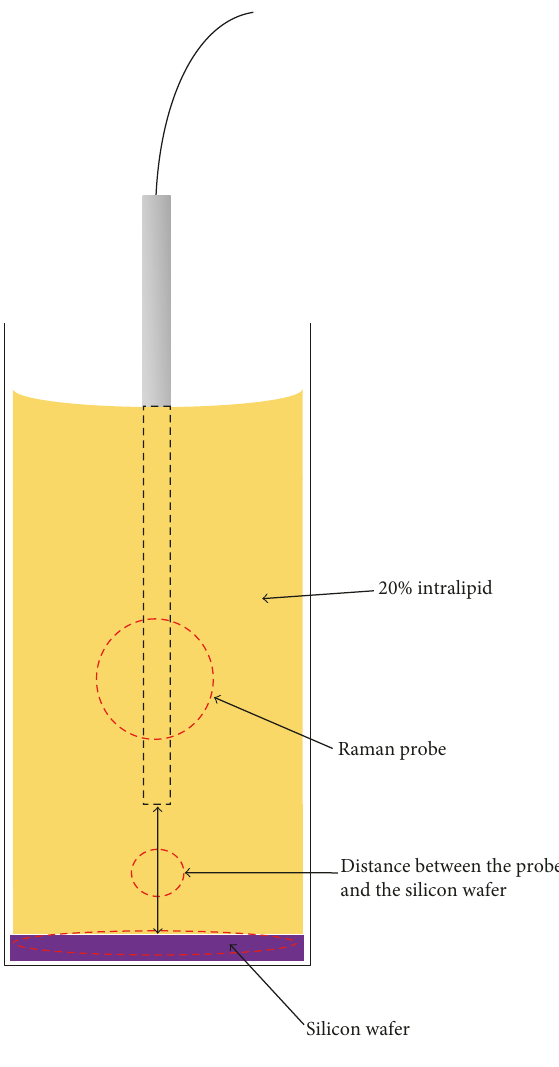
Figure 3: Schematic of a setup to check the sensitive depth of the Raman probe. A silicon wafer was placed at the bottom in a cuvette. The cuvette was fi lled with 20% intralipid solution. Raman probe was immersed in the intralipid solution. The distance between the silicon wafer and the probe end tip was varied from 0 μ m to 1000 μ m incrementing the distance by 100 μ m using a one-axis linear translation stage.